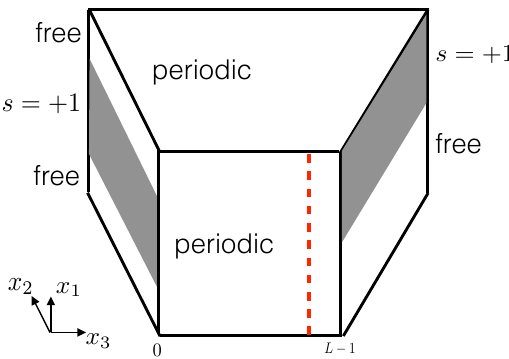
3 = 0 and x 3 = L (cid:0) 1 faces have L L cube with parallel sides. The red dashed (cid:2) (cid:2)